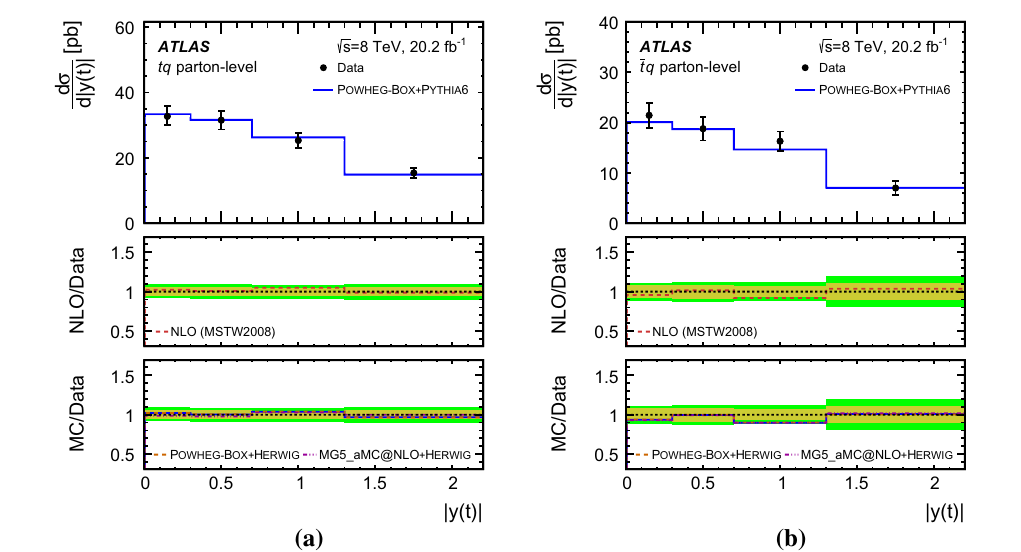
Fig. 22 Absolute unfolded differential cross-sections as a function of | y ( t ) | for a top quarks and b top antiquarks. The unfolded distributions are compared to a QCD NLO calculation and various MC predictions The vertical error bars on the data points denote the total uncertainty. The dashed ( red ) line in the central distribution shows the NLO pre- diction calculated using MCFM. The bottom distribution compares the